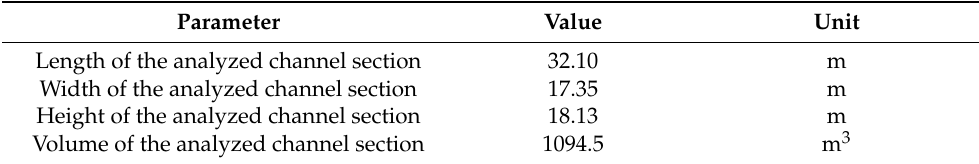
Table 1. The basic geometrical dimensions of the analyzed channel section. Parameter Value Unit Length of the analyzed channel section 32.10 m Figure 4. The four geometric variants seen from above, numbered from G1 to G4. Width of the analyzed channel section 17.35 m Height of the analyzed channel section 18.13 m Volume of the analyzed channel section 1094.5 m